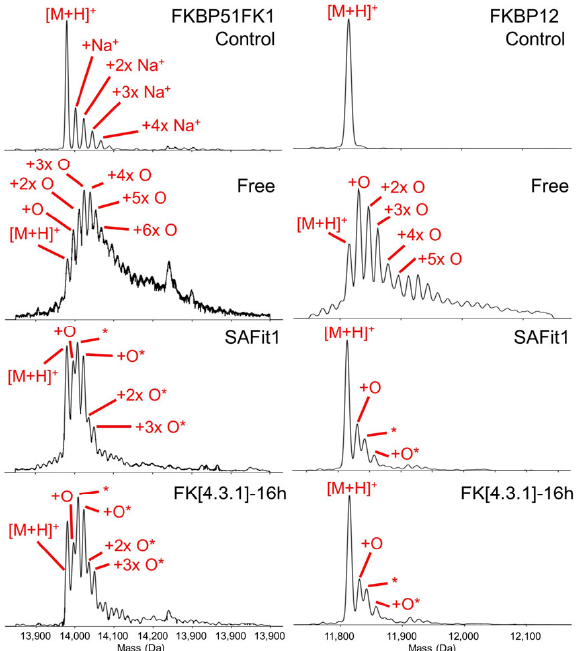
Figure 7. Intact mass measurement of FKBP51FK1 and FKBP12 (deconvoluted spectra shown) under denaturing conditions before (control; top panel) and after oxidative footprinting, either in the absence (second row; ‘free’ protein) or presence of ligands SAFit1 and FK[4.3.1] ‐ 16h. Peaks labelled with an asterisk carry an additional modification of 27.01 Da.